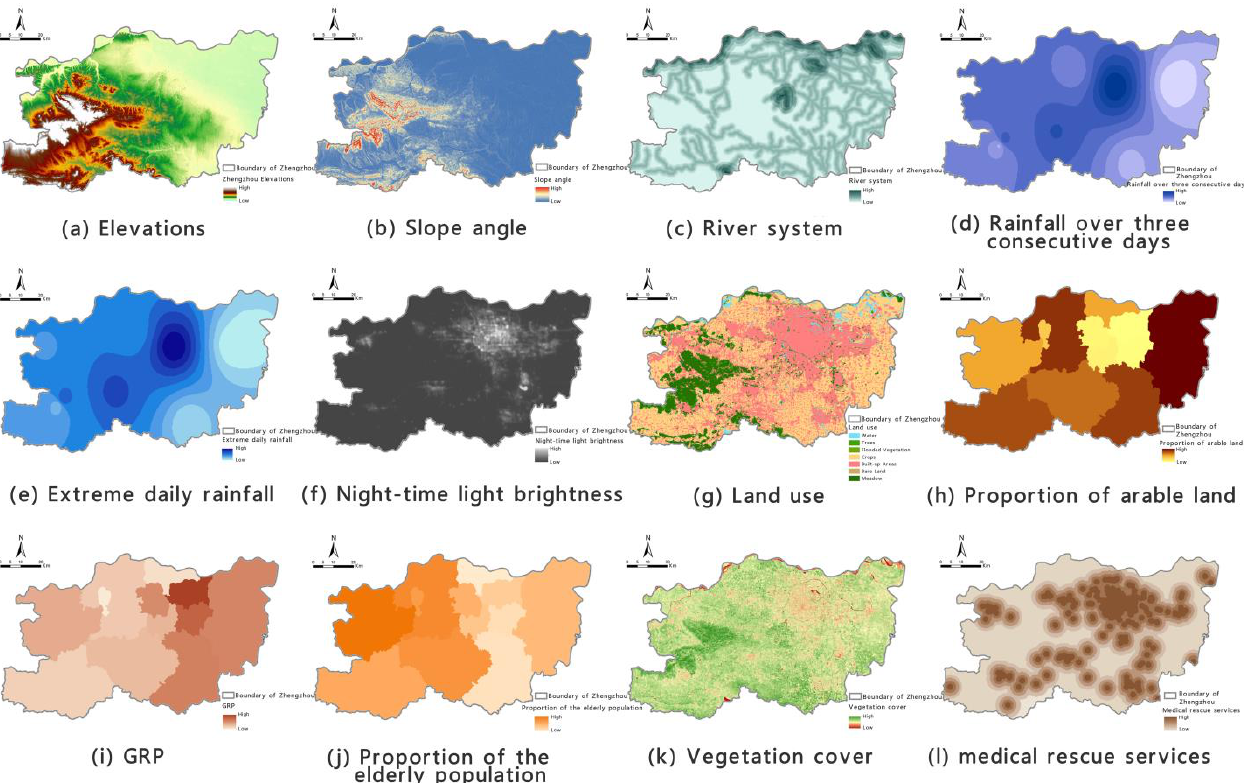
Figure 5. Diagrams of individual precipitation-induced flooding risk-assessment factors.